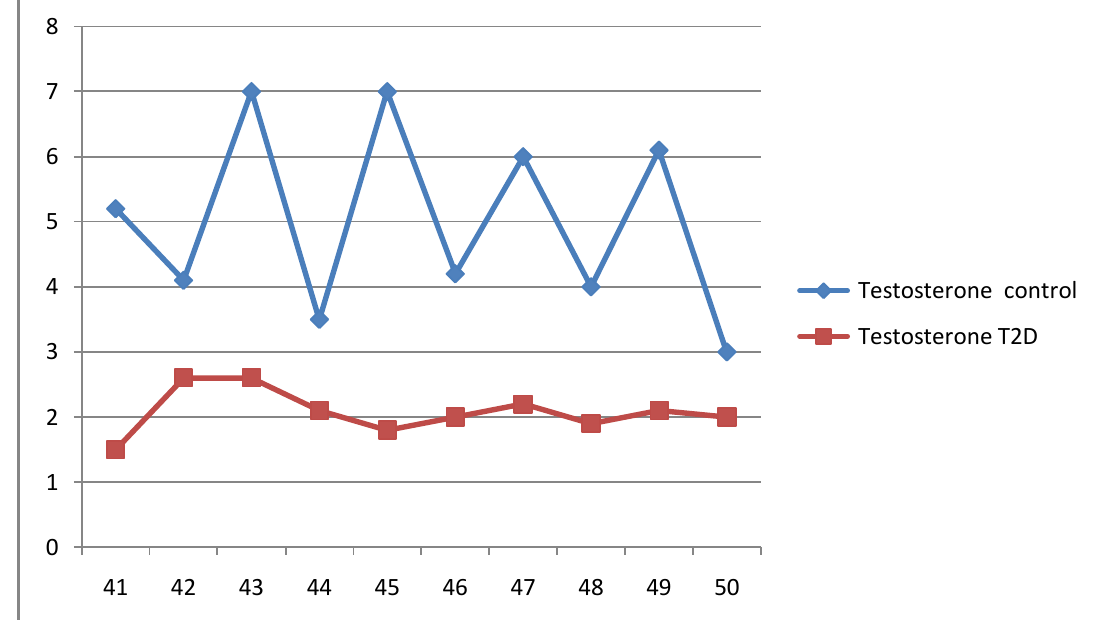
Diagram (2): Testosterone levels in Group B :Showing levels of Testosterone with age in control group{above} and in T2D group {under}. *Ventricle axon refers to Testosterone levels( µ g/ml) & Horizontal axon refers to Age